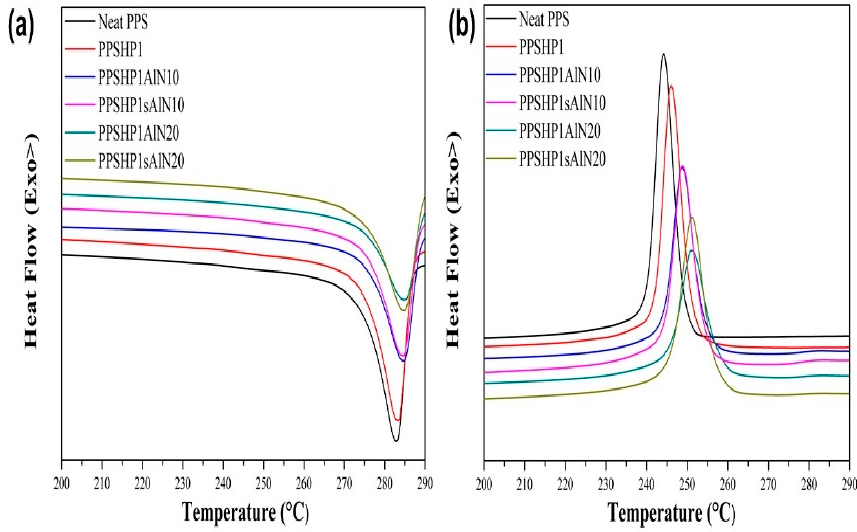
Figure 9. DSC ( a ) melting curve and ( b ) cooling curve for 10°C/min heating rate of the PPS/